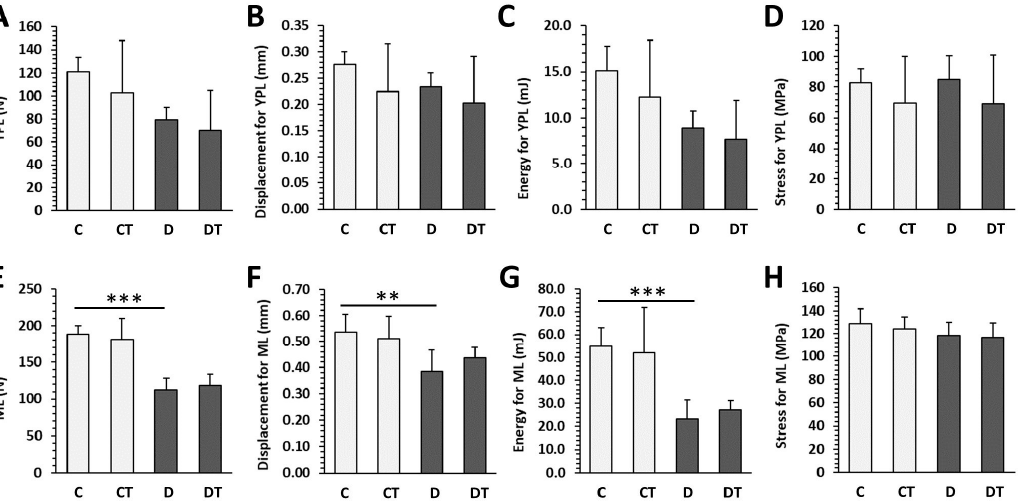
Figure 7. Mechanical properties of femoral bones in non-diabetic rats (C), those treated with cemtirestat (CT), STZ-induced diabetic rats (D), and those treated with cemtirestat (DT). ( A – D ) Yield point load (YPL) displacement, energy, and stress, ( E – H ) maximum load (ML) displacement, energy and stress. The values are represented as mean ± SD. Only differences between groups C and D, as well as C and CT, and D and DT are indicated (** p < 0.01, *** p <